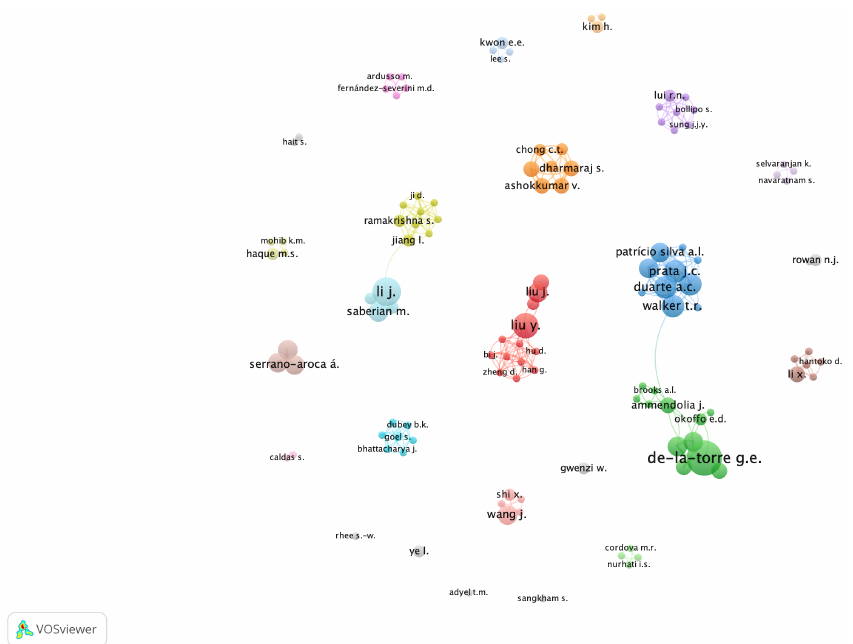
Figure 9. Author collaboration network visualization, including authors with a minimum of 50 citations.